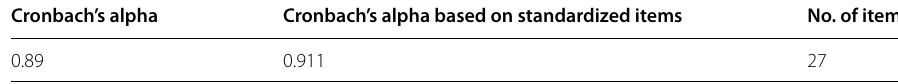
Table 1 Reliability statistics of the questionnaire